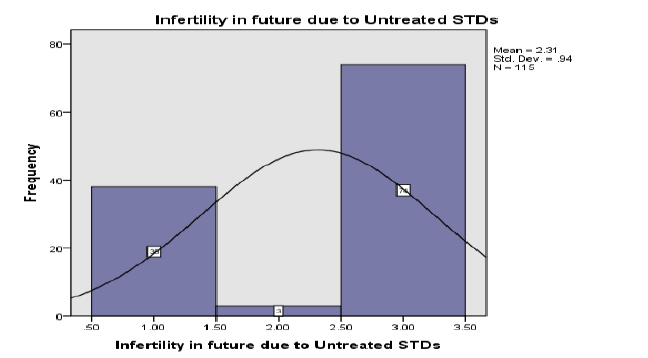
Figure 2: Knowledge of Risk factors associated with STD among women